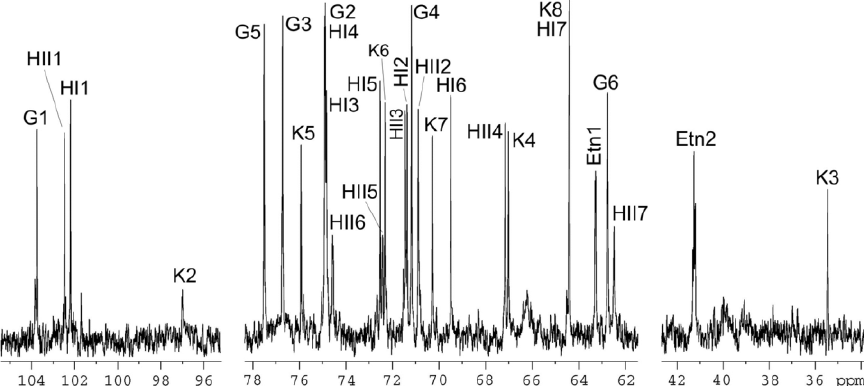
Figure 6. 13 C-NMR of core OS obtained by mild acid hydrolysis from LPS isolated from